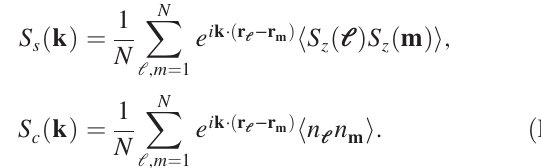
˜ S k ; π Þ and (d) charge density ˜ S k ; 0 Þ versus k s ð x c ð x x on segments of a